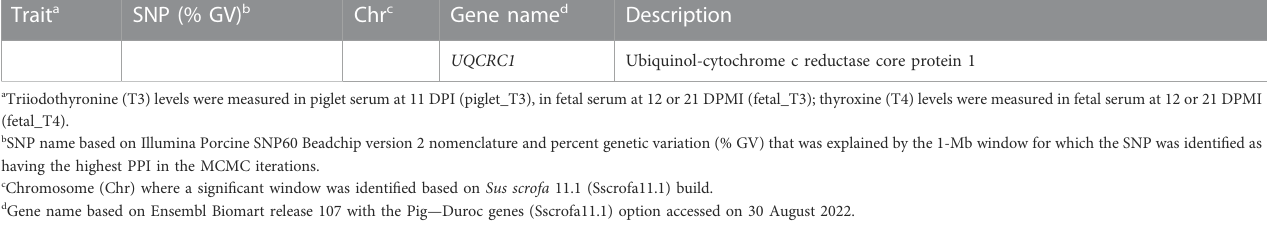
TABLE 5 ( Continued ) Positional candidate genes for the top SNP based on percentage of GV explained for each trait. Trait a SNP (% GV) b Chr